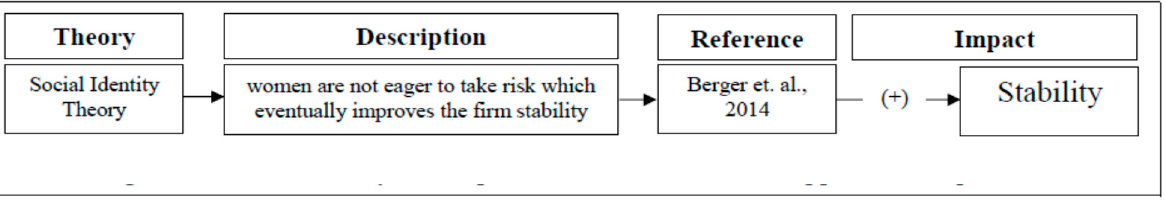
Figure A3. Firm stability: conceptual model based on multi-approach perspective.